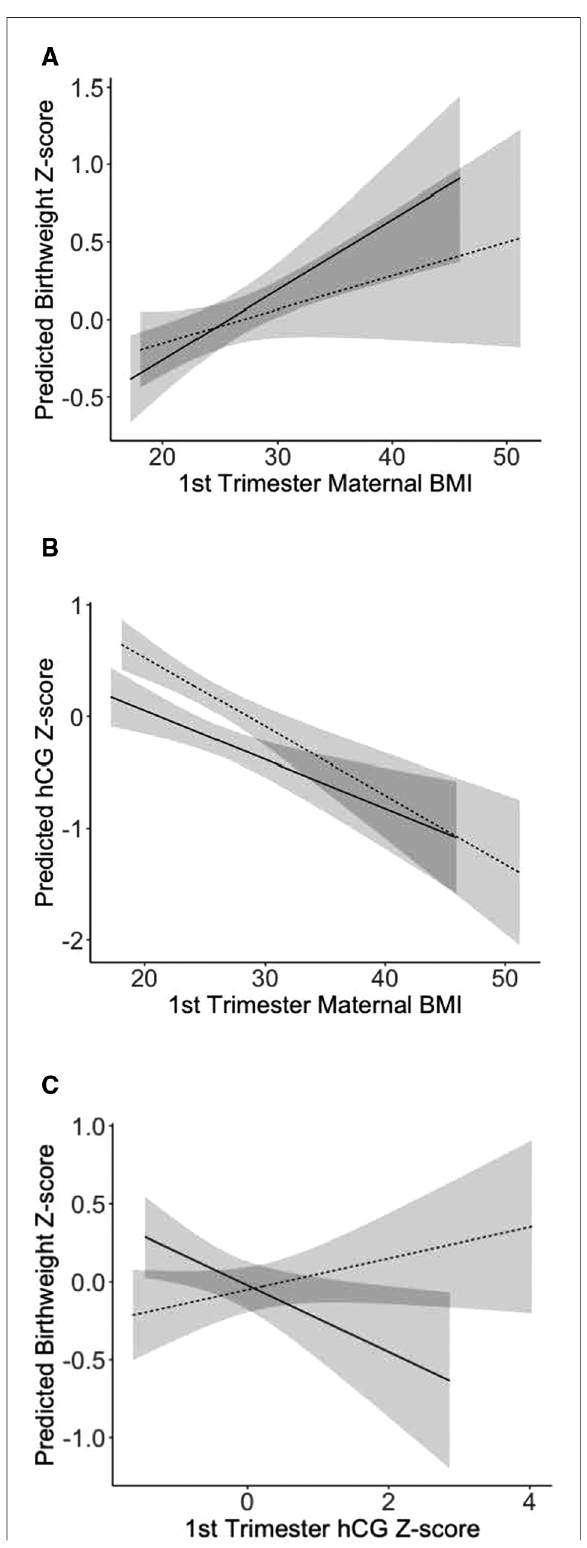
FIGURE 2 Linear associations between ( A ) maternal fi rst trimester BMI and birthweight; ( B ) fi rst trimester BMI and hCG; ( C ) fi rst trimester hCG and birthweight for women carrying male and female fetuses in the infant development and environment study (TIDES), 2010 – 2013. Solid lines represent women carrying male fetuses, and dashed lines represent women carrying female fetuses. 95% con fi dence intervals are shaded around the lines. BMI, body mass index; hCG, human chorionic